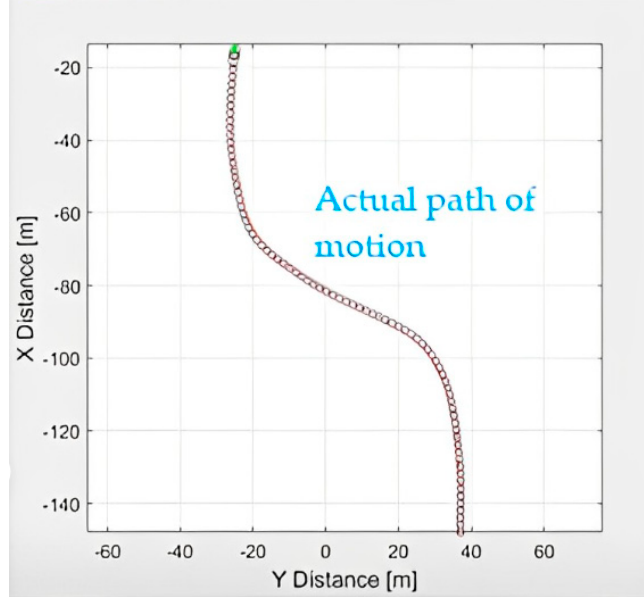
Figure 6. Desired path of motion.